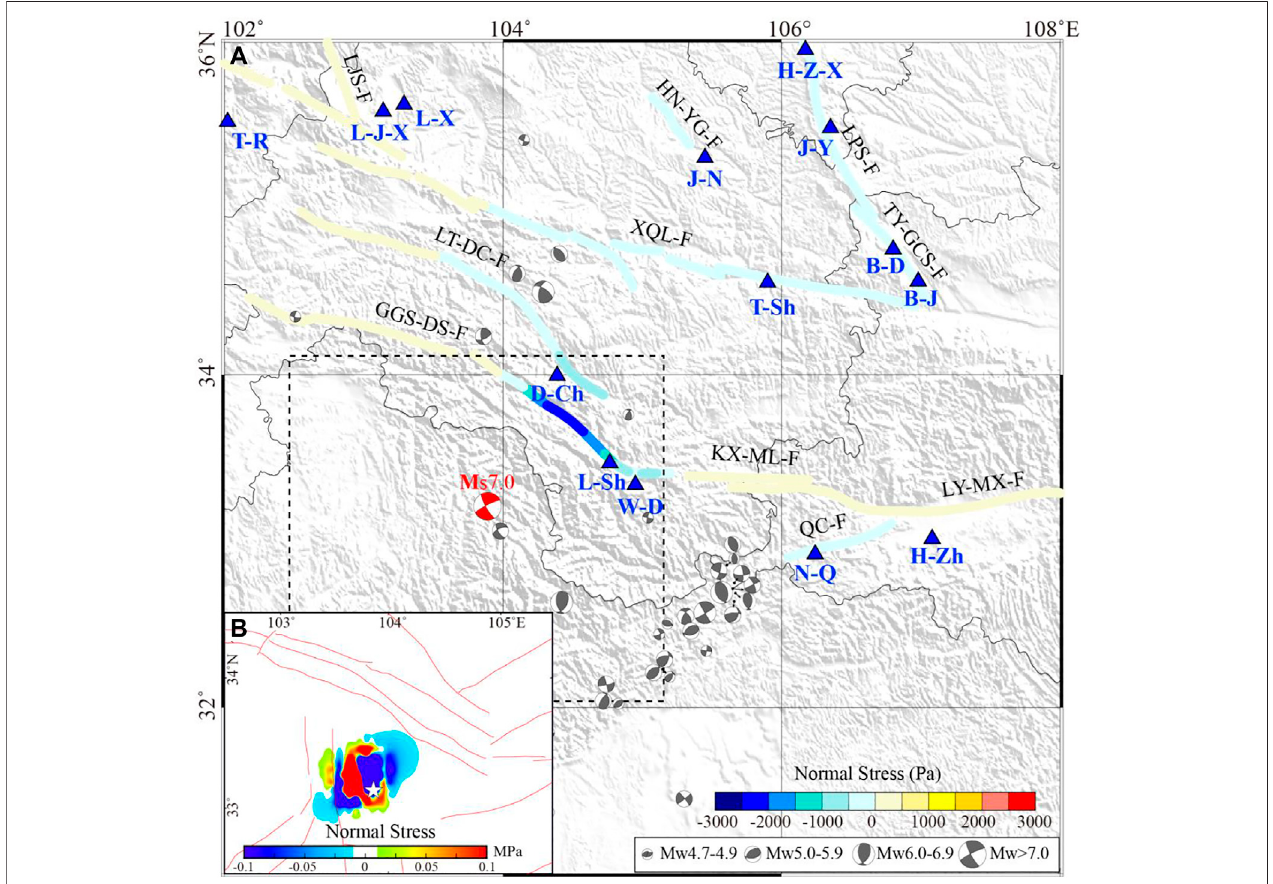
FIGURE5| Surfaceco-seismicnormalstresschangesinducedbyJZGEQ. (A) Resultsofthesourcearea.Whitepentagram:epicenterofJZGEQ;Redlines:faults. (B) Results of thereceivingfaults. Blue triangle: strain stations; Gray focal mechanism solution: history earthquake since 1976 (cite from GCMT),including four sizes, 4.7 ≤ MW < 4.9,5 ≤ MW < 5.9,6 ≤ MW < 6.9,andMW > 7;Redfocalmechanismsolution:JZGEQ;Thecoloredlines:receivingfaults; GGS-DS-F:GuangGaiShan – DieShan fault; LT-DC-F: LinTan-DangChang fault; KX-ML-F: KangXian-Mianlue fault; QC-F: QingChuan fault; LY-MX-F: LueYang – MianXian fault; XQL-F: North margin of XiQinLing fault; TY-GCS-F: TaoYuan-GuiChuanSi fault; LPS-F: East margin of LiuPanShan fault; HN-YG-F: HuiNing-YiGang fault; LJS-F: LaJiShan fault.